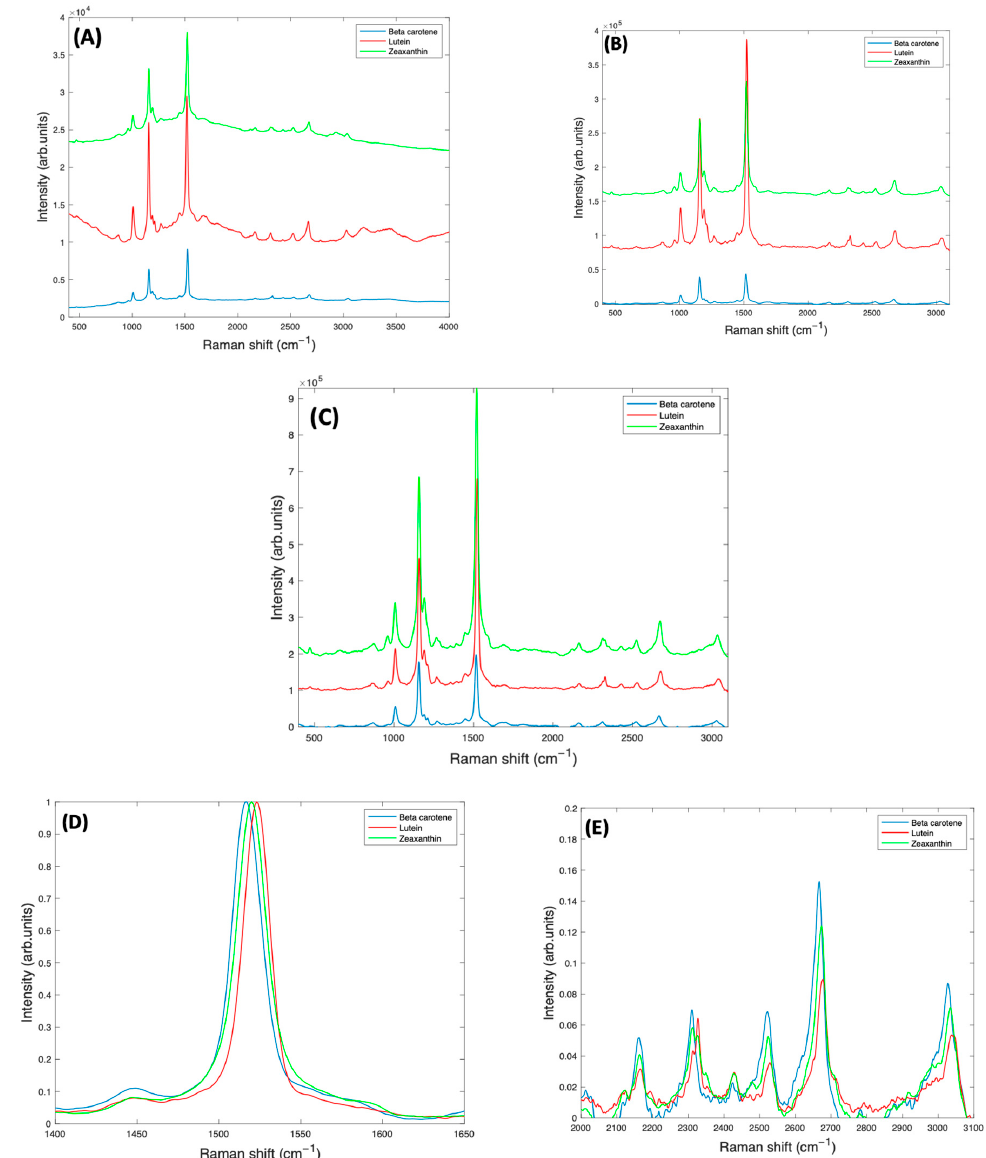
Figure 7. ( A ): Smoothed Raman spectra of 1 mg/mL BSA complex solutions of Beta Carotene, Lutein, and Zeaxanthin, taken at 532 nm, with a ×10 objective lens. ( B ): Corrected Raman spectra of 1 mg/mL BSA complex solutions of Lutein, Beta Carotene, and Zeaxanthin, before self-absorbance correction and offset for clarity. ( C ): Raman spectra of 1 mg/mL BSA complex solutions of Lutein, Beta Carotene, and Zeaxanthin, after self-absorbance correction and offset for clarity. A more detailed comparison of normalised spectra of Beta Carotene, Lutein, and Zeaxanthin is also shown ( D ) in the region of the largest peak at ~1519 cm − 1 ( E ) in the region > 2000 cm − 1